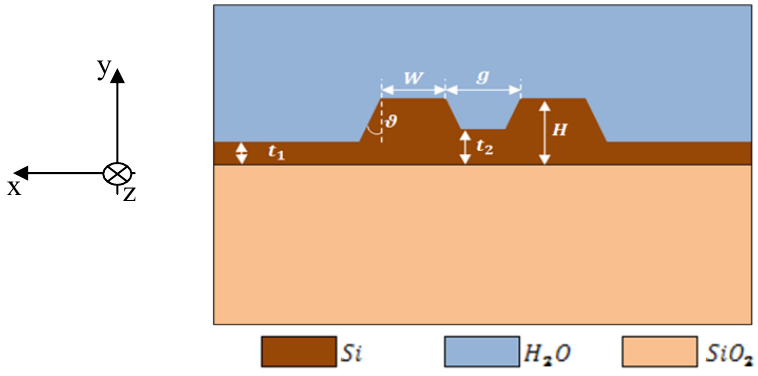
Figure 1. Schematic view of slot waveguide cross section. H and W are photonic wires height and width, respectively, g is the gap width, t outside and inside the gap region, respectively, and ϑ is the slanted sidewall